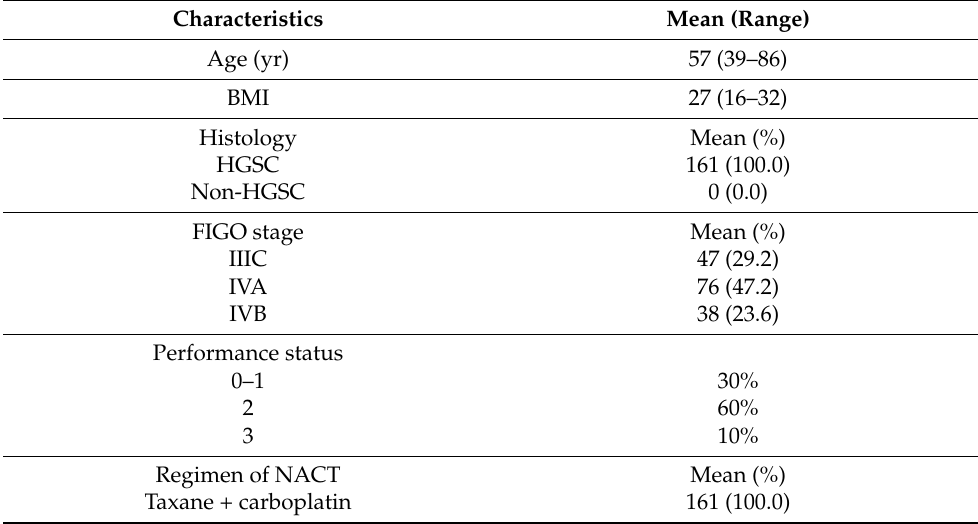
Table 1. Patients’ clinical characteristics.